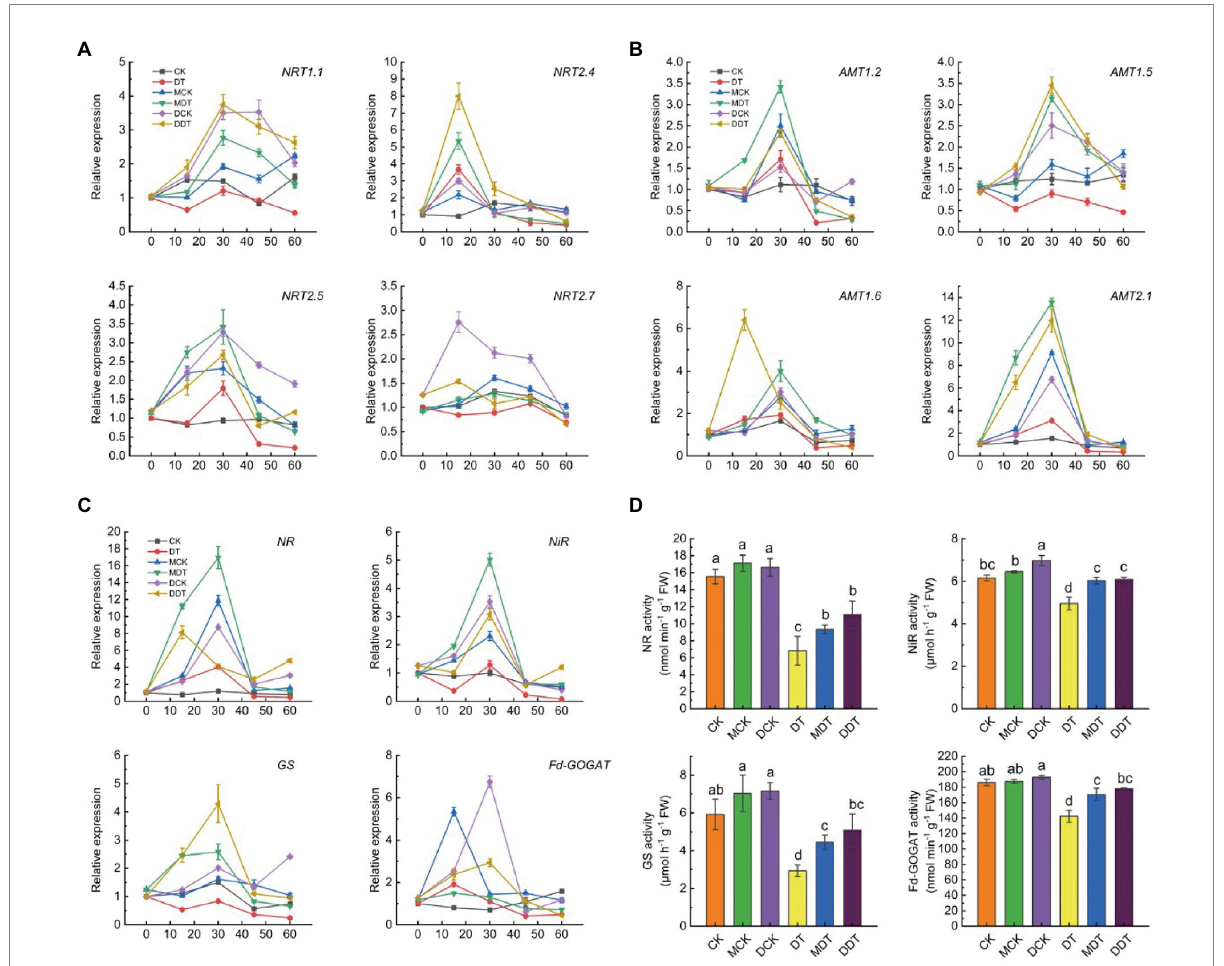
FIGURE 3 Dynamic changes of N transport [ (A) NRTs : NRT1.1 , NRT2.4 , NRT2.5 and NRT2.7 ; (B) AMTs : AMT1.2 , AMT1.5 , AMT1.6 and AMT2.1 ] and metabolism ( C : NR , NiR , GS , and Fd-GOGAT ) associated genes and final N metabolic enzyme activity (D) in leaves under different treatment. Data are means ± SD ( N = 3). For each panel, bars not labeled with same letter indicate significant differences at p < 0.05, based on Tukey’s multiple range tests.